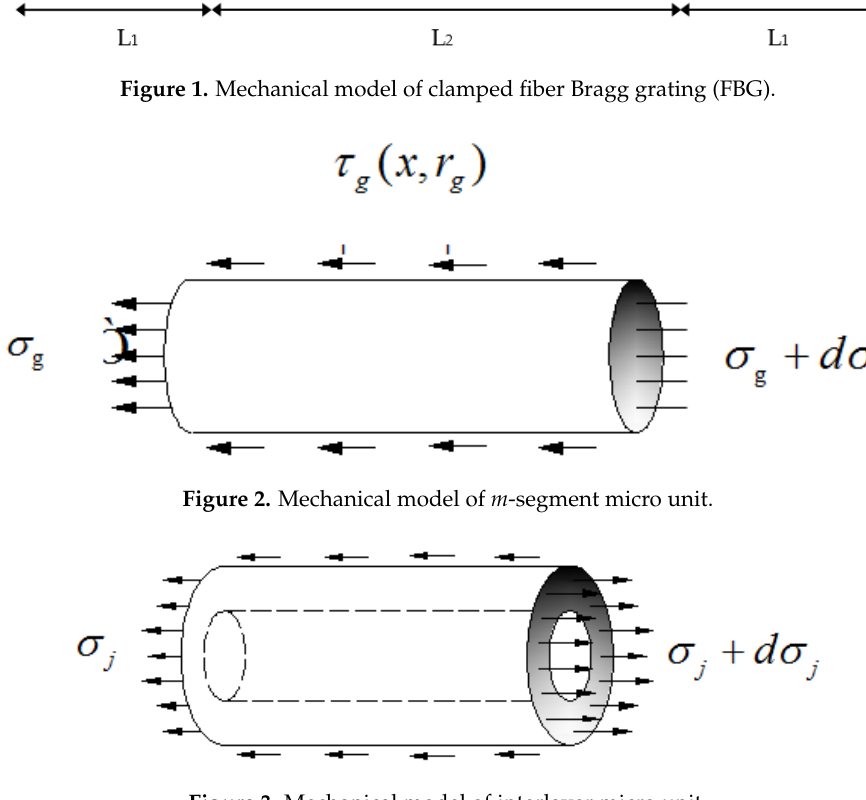
Figure 1. Mechanical model of clamped fiber Bragg grating (FBG).